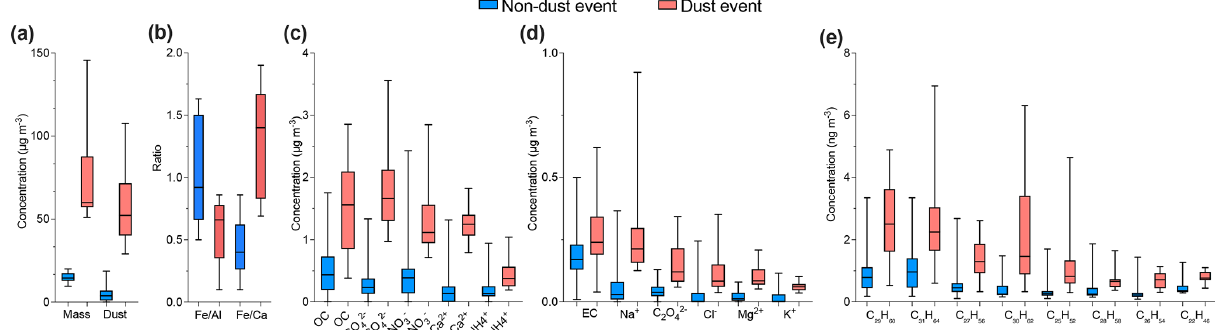
Figure 10. Box plot in the period of dust and non-dust events for concentrations of (a) PM 10 mass and mineral dust, (b) Fe / Al and Fe / Ca ratios, (c) OC and major water-soluble ions, (d) EC and minor water-soluble ions, and (e) organic